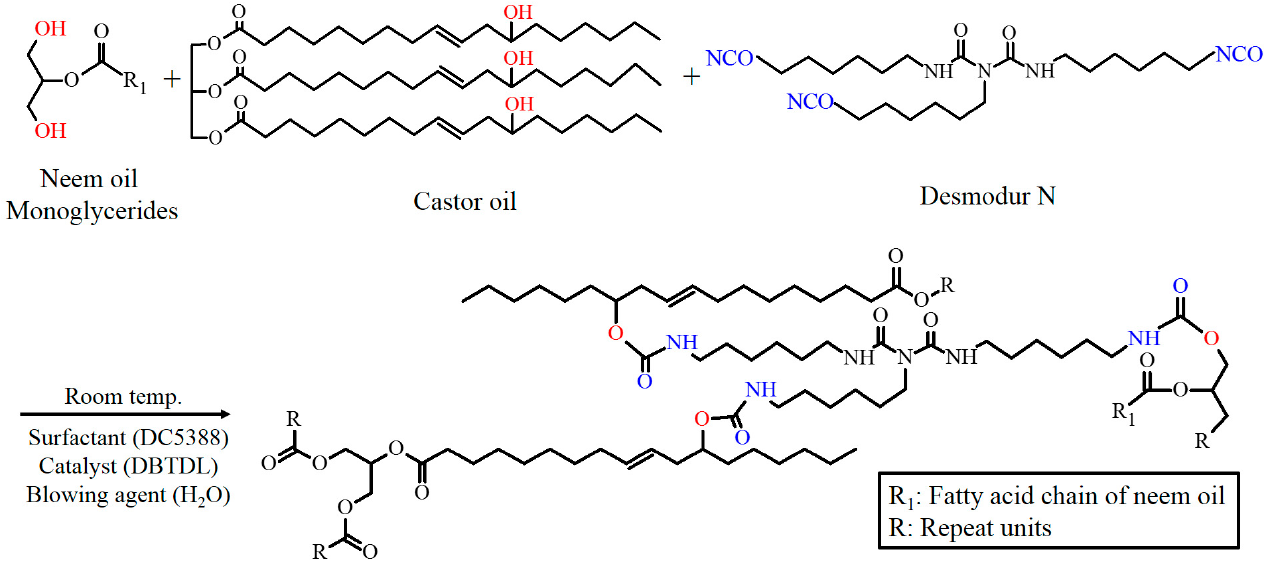
Figure 1. Chemical synthesis route for bio-based PU foam.